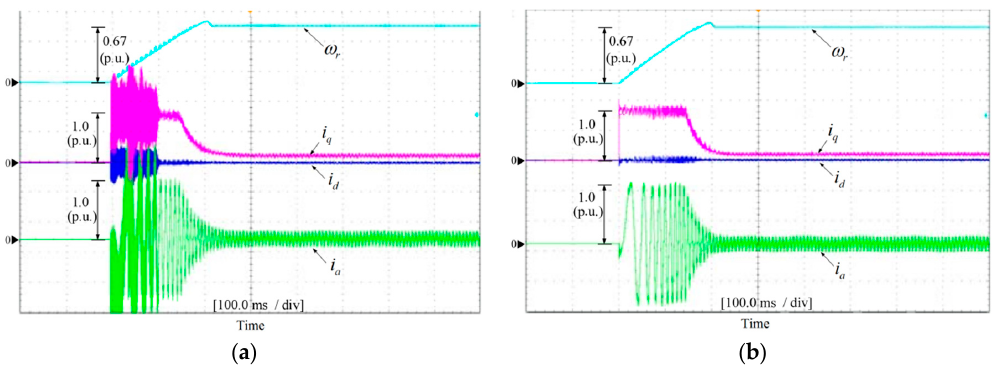
Figure 10. Experimental results of motor starting with mismatched inductance: ( a ) TBC; ( b ) AIBC_FP.